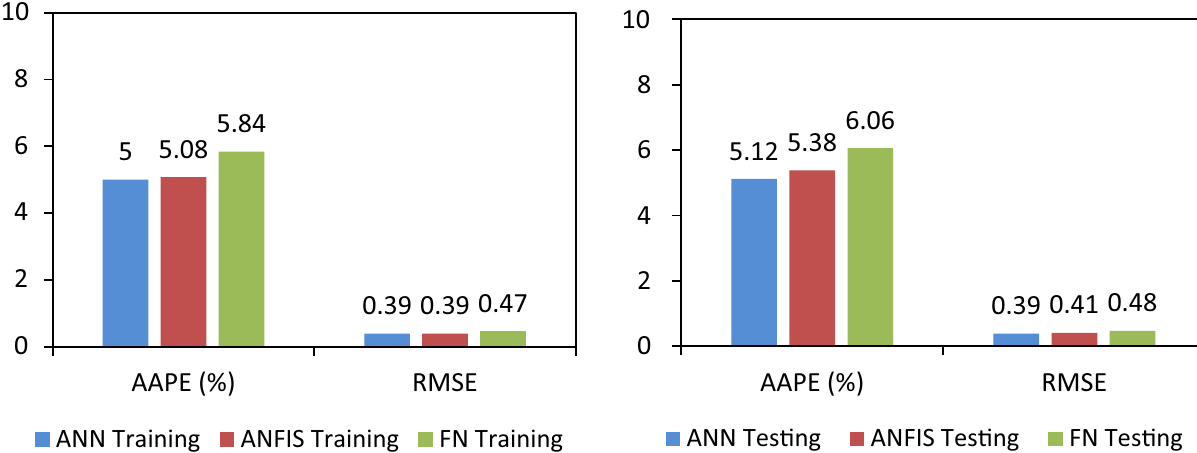
Figure 13. Error comparison of for training and testing dataset for ANN, ANFIS and FN prediction